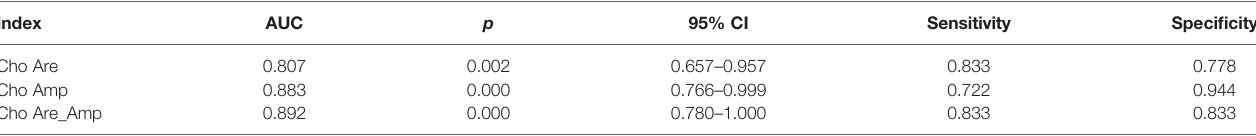
TABLE 2 | Diagnostic ef fi ciency of Cho Are, Cho Amp, and Cho Are_Amp in VX2 liver cancer.